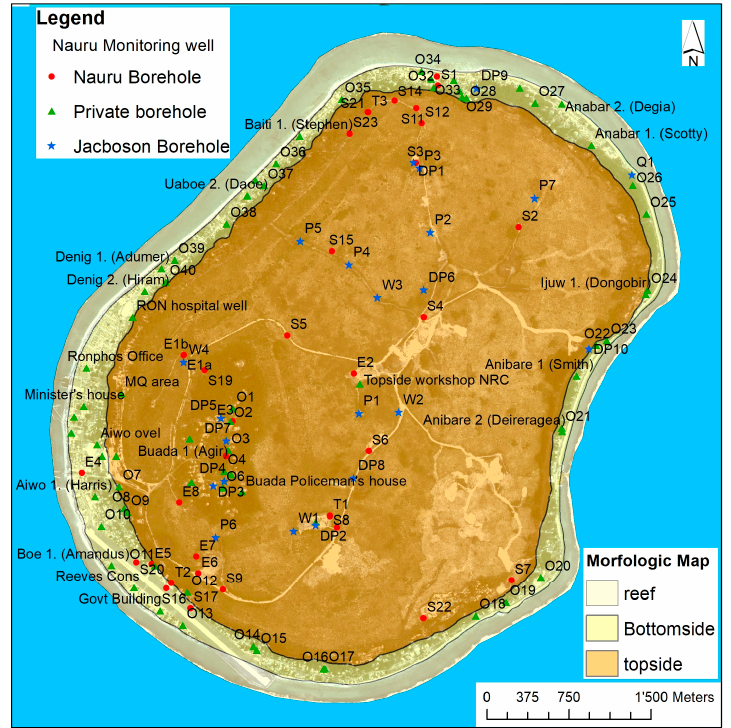
Figure 3. Reef, Bottomside and Topside of Nauru and location of wells and monitoring wells present in the island.